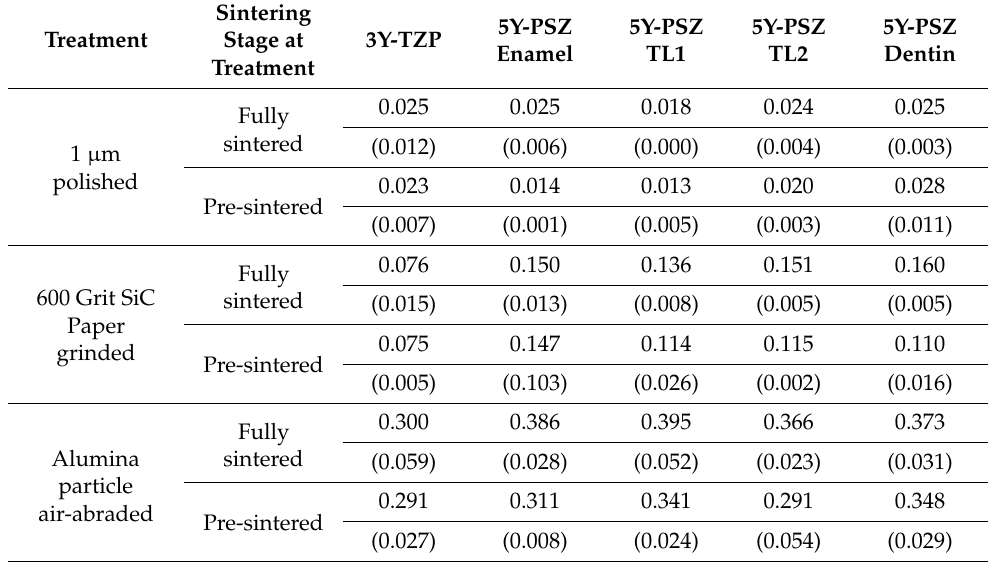
Table 2. Means (SD) in µm (Ra) of Surface roughness measured with laser scanning microscopy.